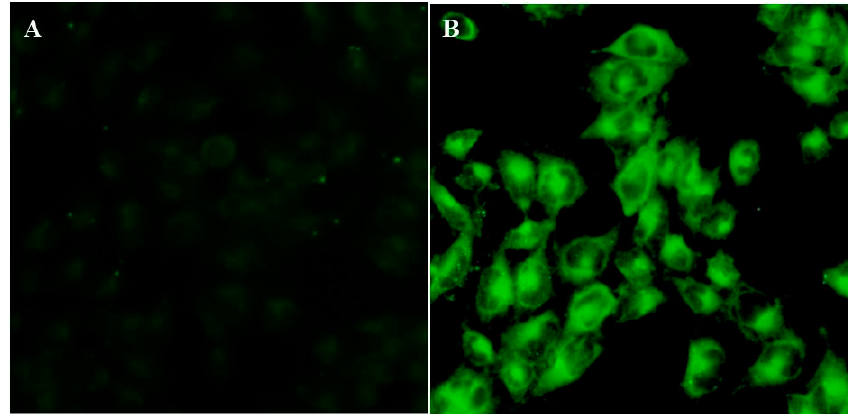
Figure 6. Fluorescence imaging of U-87 MG cells after 2 h of incubation. ( A ) Cells incubated with curcumin not showing any fluorescence; ( B ) Cells incubated with CSLNs showing an intense green fluorescence revealing the efficient uptake of CSLNs by these cells.